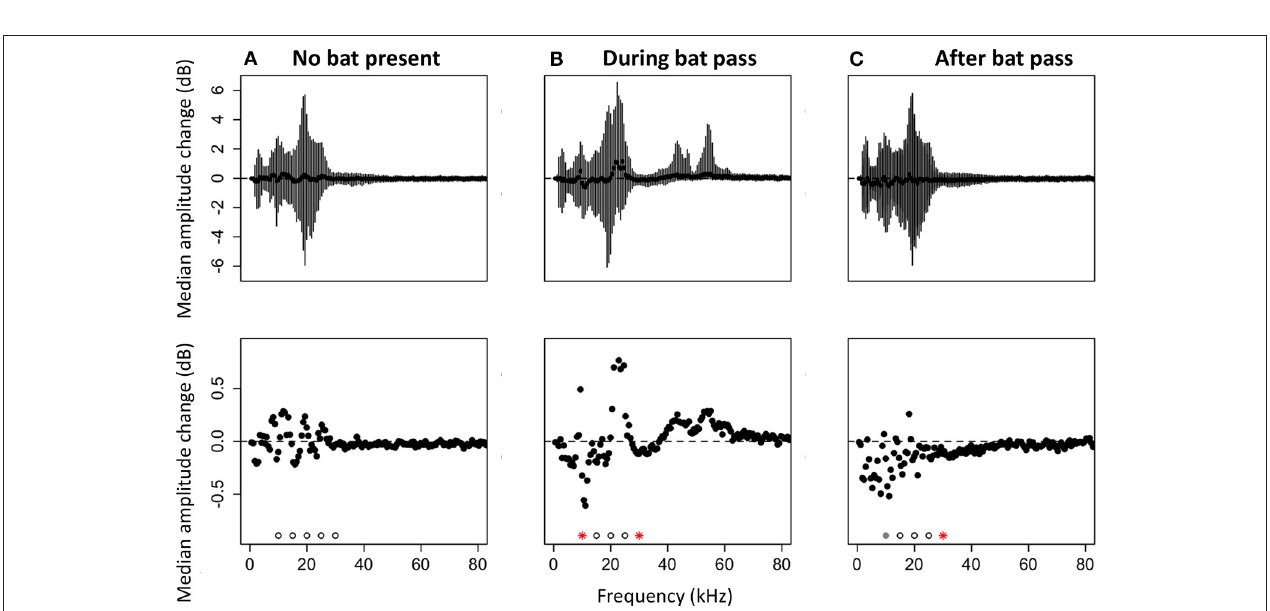
FIGURE 4 | Median changes in amplitude by frequency. Negative values indicate less energy in the second time bin. (A) Median amplitude change between two time bins in a recording without echolocation calls ( N = 246 recordings). (B) Median amplitude change comparing time bins before and during an echolocation sequence of a bat ( N = 250 recordings). (C) Median amplitude change comparing time bins before and after an echolocation sequence of a bat ( N = 210 recordings). Top panels: medians with error bars representing the 25th to the 75th percentile. Bottom panels: same data as top panels, but scaled in to show just the median values. Significance was tested at 5kHz intervals from 10 to 30kHz. Significant differences are shown with red asterisks (Wilcoxon paired ranks sums tests, p < 0.05), marginally significant differences are shown with gray circles (0.05 < p < 0.1), and tests that were not significant are shown with open